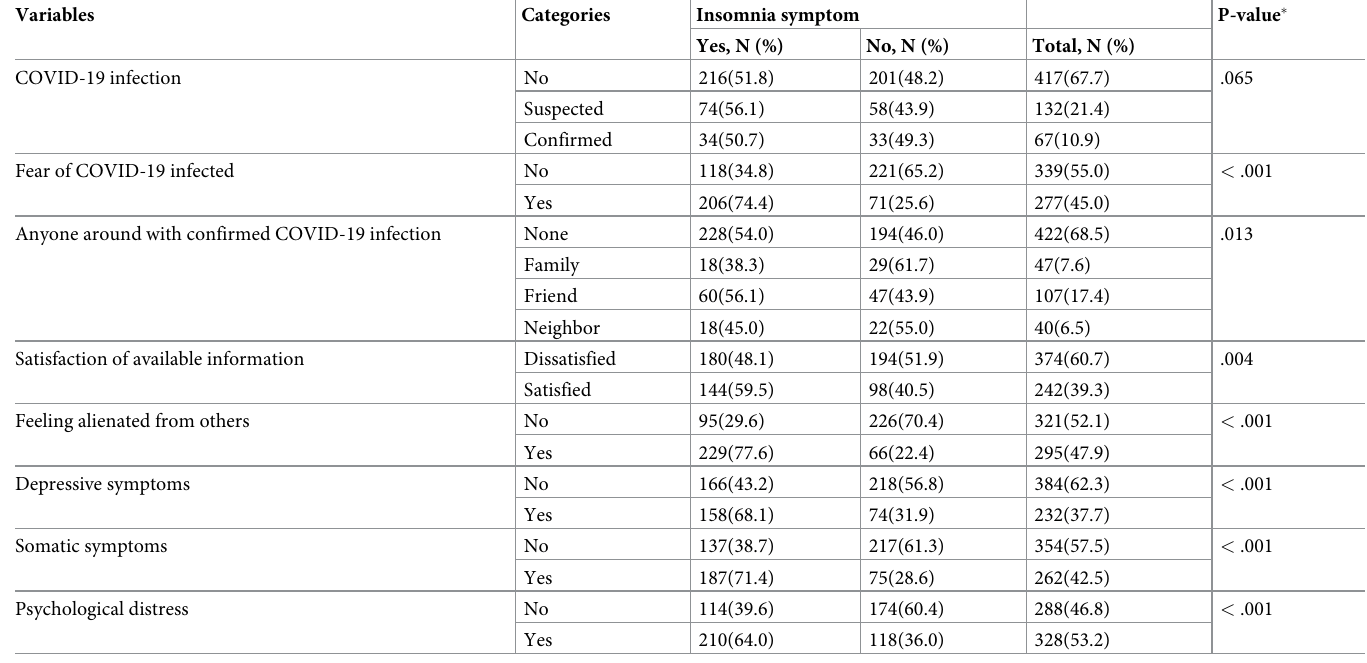
Table 2. COVID-19-related perception and insomnia